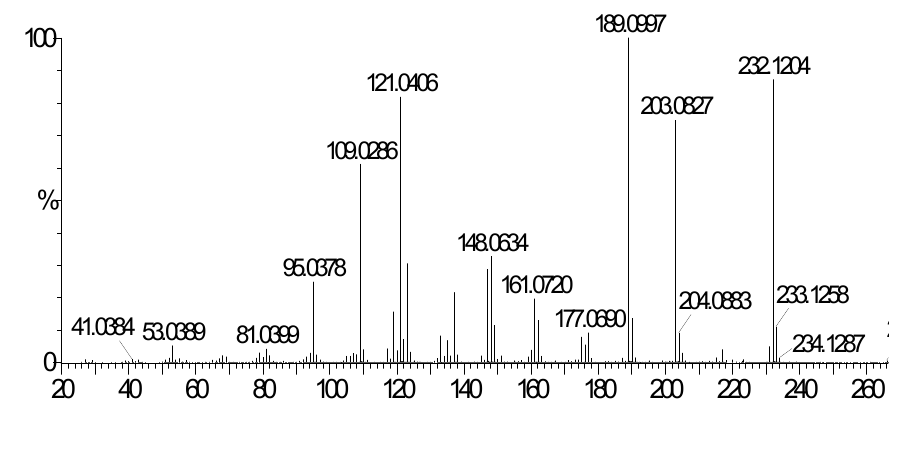
Figure 9. HRMS data of the compound